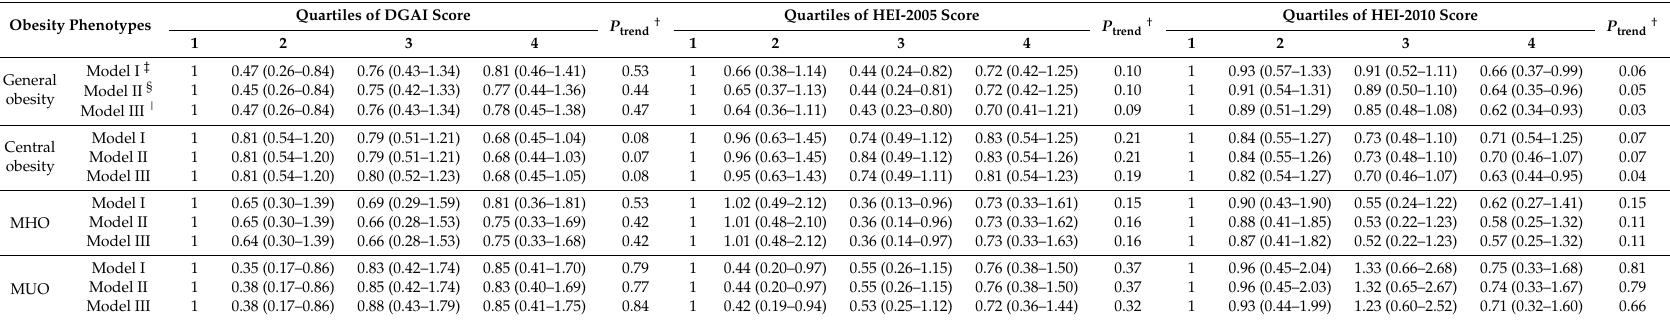
Table 6. Odds ratio (95% CI) for central obesity, general obesity, metabolically healthy obesity and metabolically un-healthy obesity across quartile categories of diet quality indices score in Tehran Lipid and Glucose Study adolescents